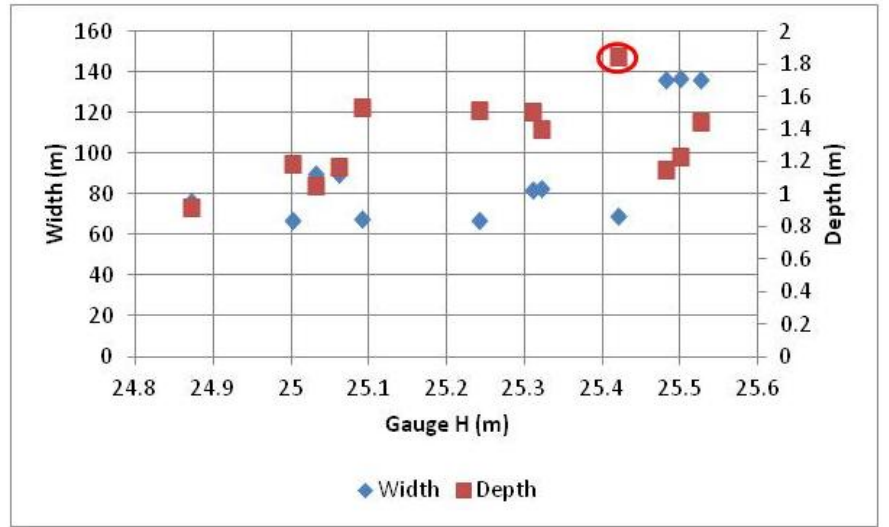
Figure 6. Complete channel width and average water depth as functions of gauge height for the Sagavanirktok River west channel near MP405 (DSS1). Bankfull water depth at the main channel is clearly defined in the plot (red oval).